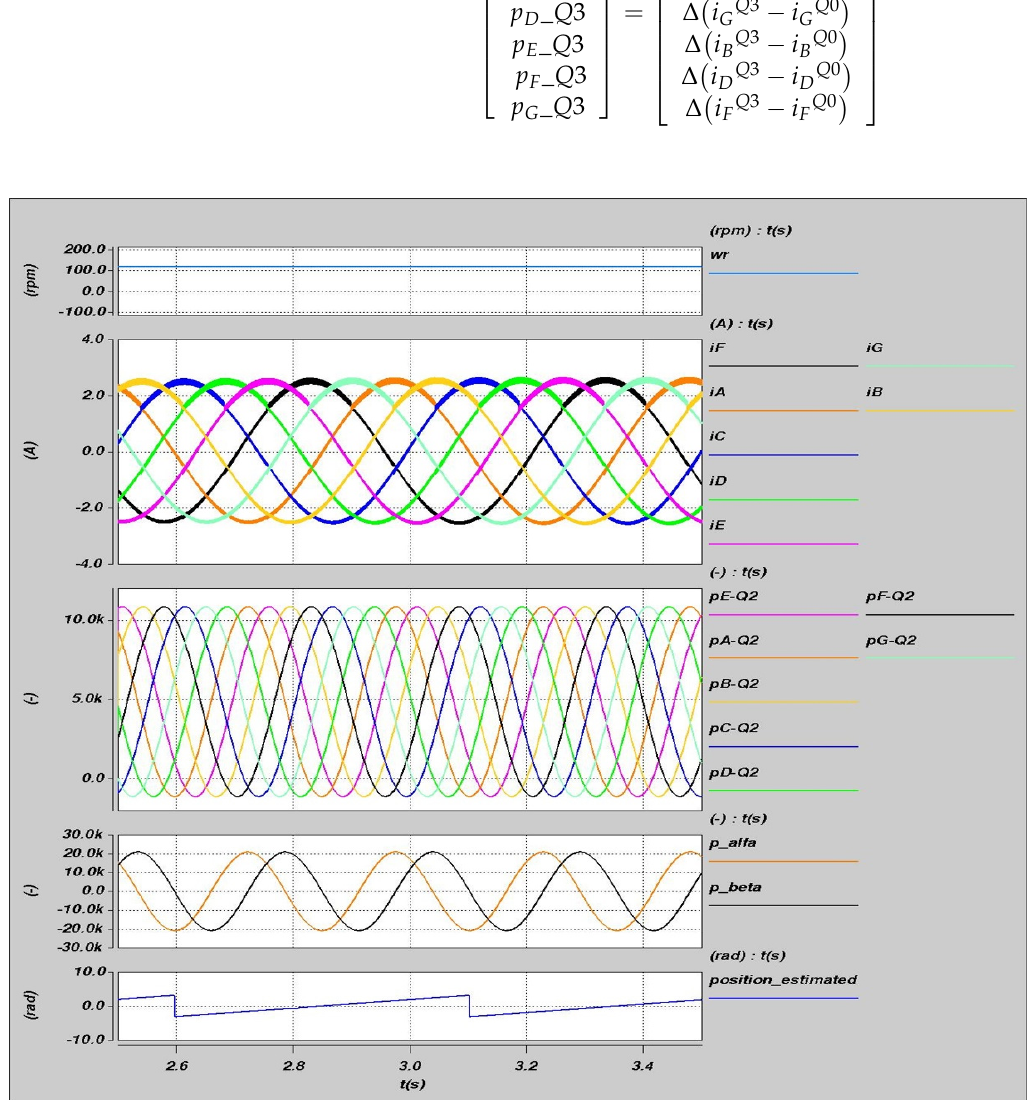
Figure 11. Saliency tracking results using the active vector Q2 (case = 1).